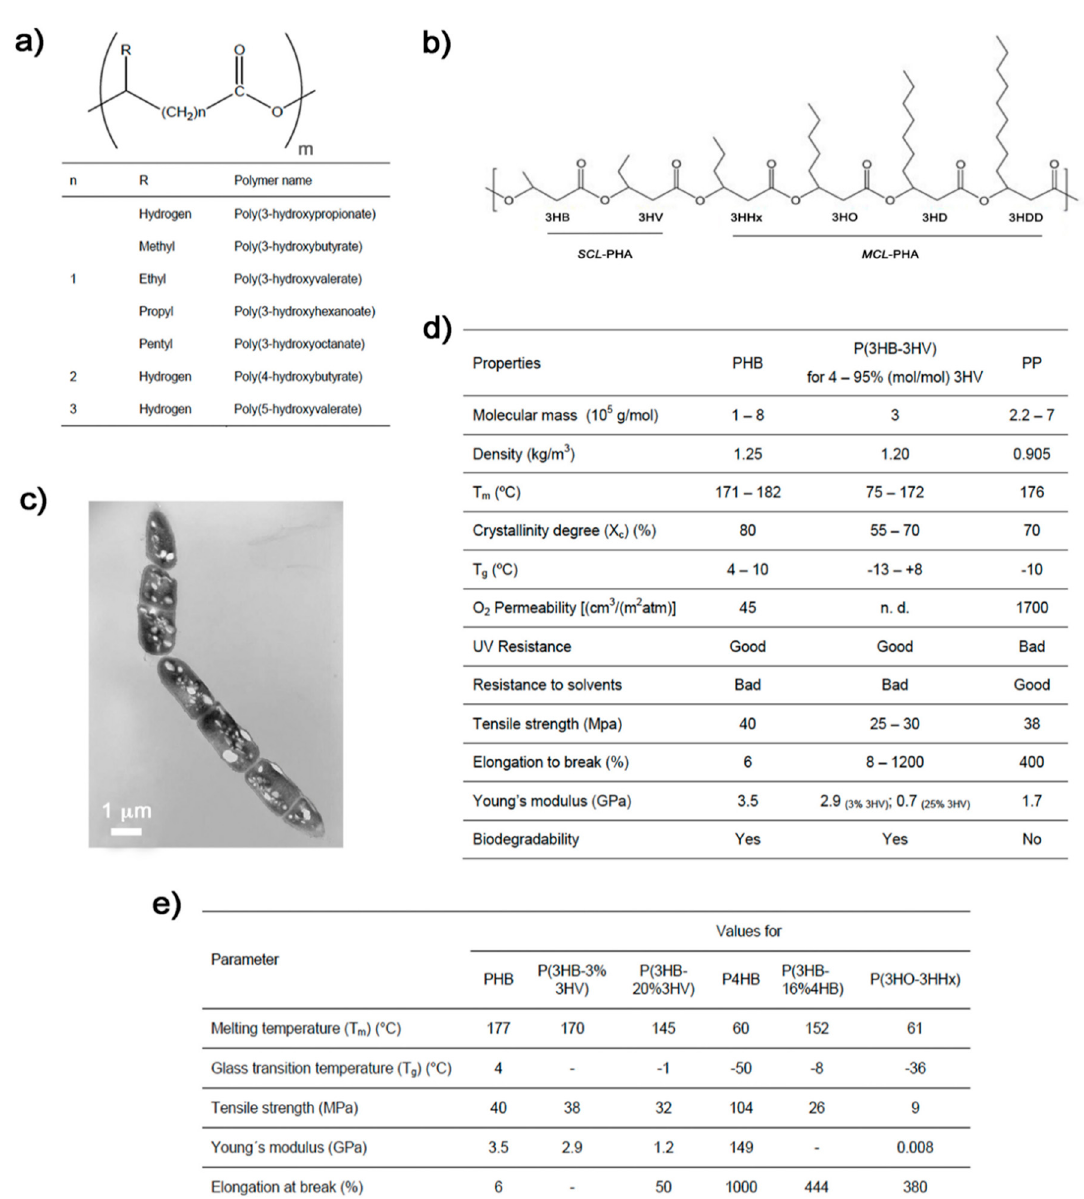
compared to those of the